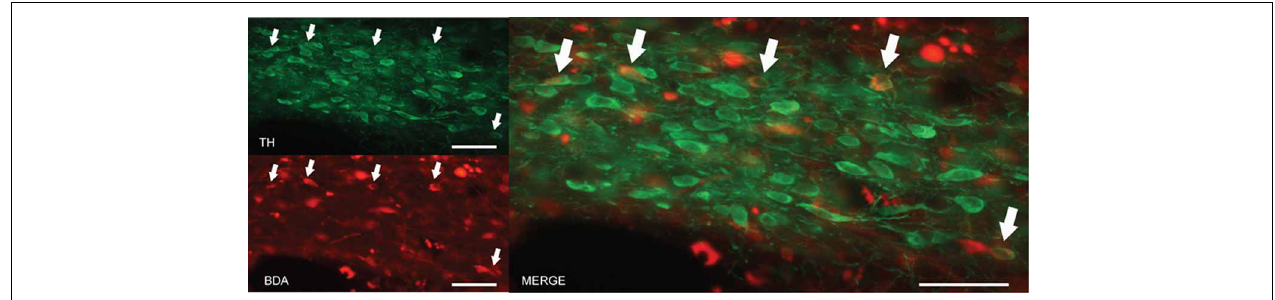
FIGURE 6 | BDA injection site in the area of the mZI, including the A13 cell group. Images from fluorescent microscopy show neurons containing the anterograde tracer (in red) and TH in (green). Double-labeled cells are indicated by arrows and appear in yellow. Scale bar is 30 μ